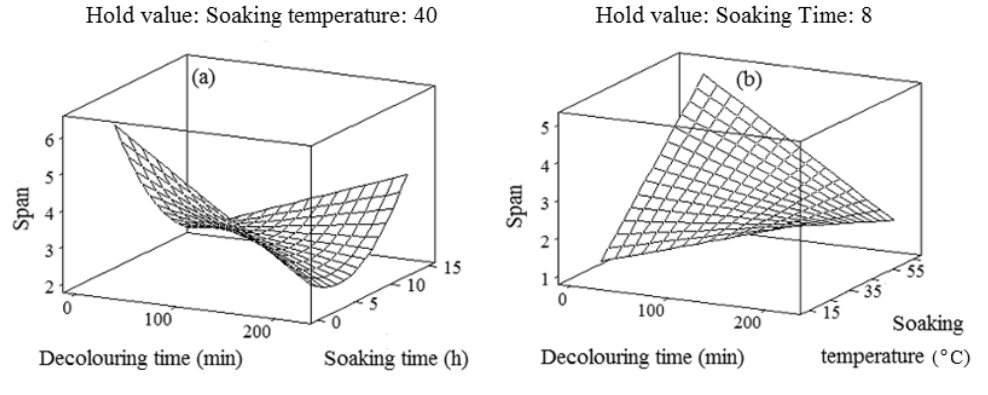
Figure 2. Response surface plots for explaining the variation of span as a function of ( a ) decolouring time and soaking time and ( b ) decolouring time and soaking